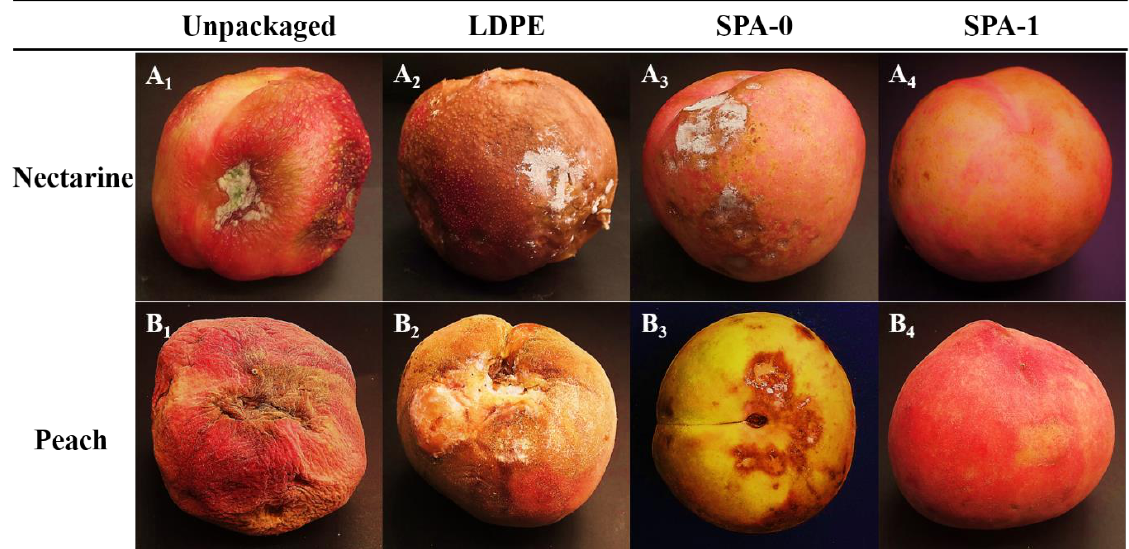
Figure 7. Photographs of nectarines and peaches after storage at 53% RH and 24 °C. A 1 – 4 : Photographs of nectarines after 9 days of storage in different types of packaging bags. B 1 – 4 : Photographs of peaches after 14 days of storage in different types of packaging bags.